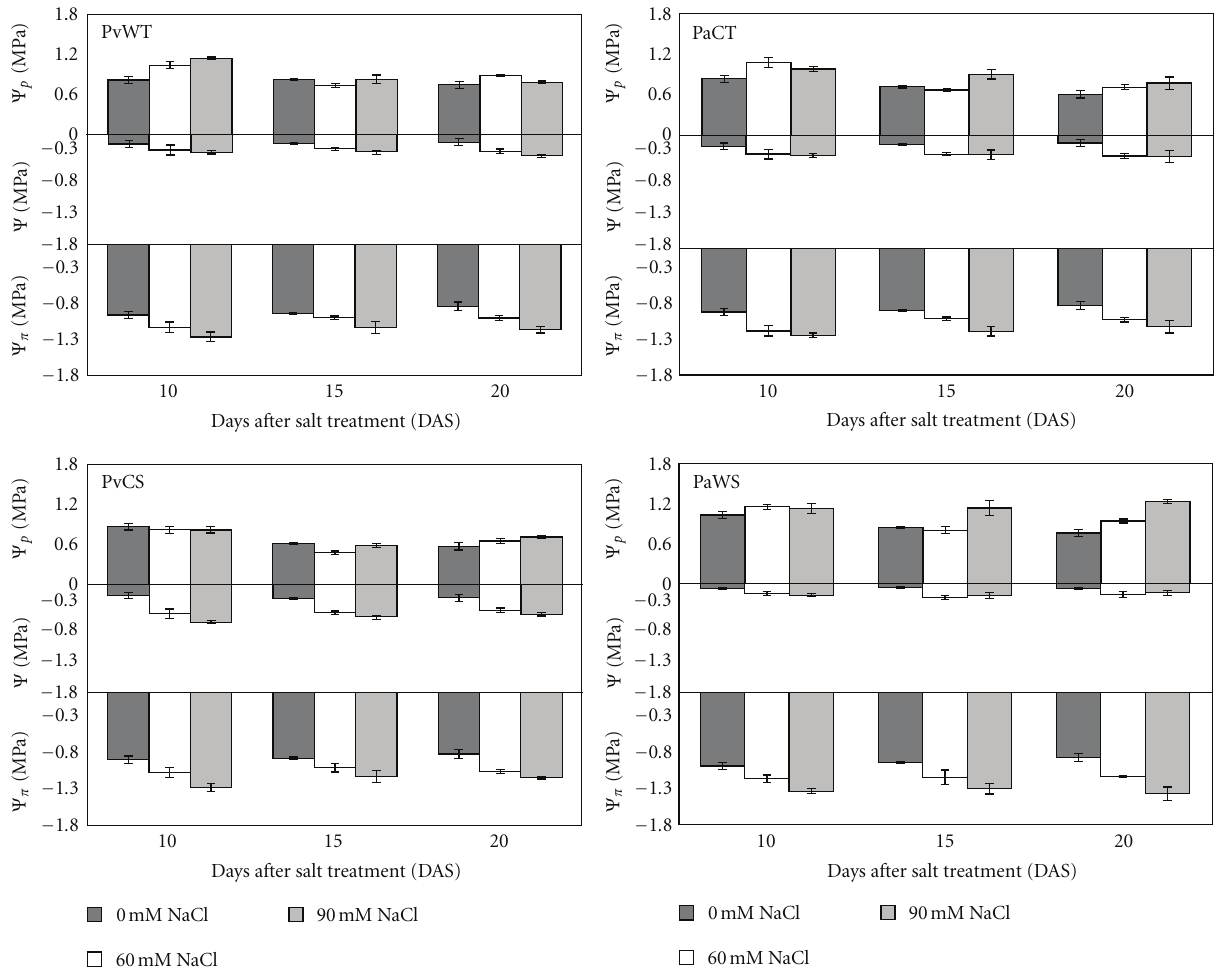
Figure 4: E ff ects of increasing NaCl levels on leaf turgor pressure ( Ψ p ), leaf water potential ( Ψ ), and osmotic potential ( Ψ π ) (in MPa) between 10 and 20 days of salt treatment for Phaseolus species. Each value represents the mean ± SE of six